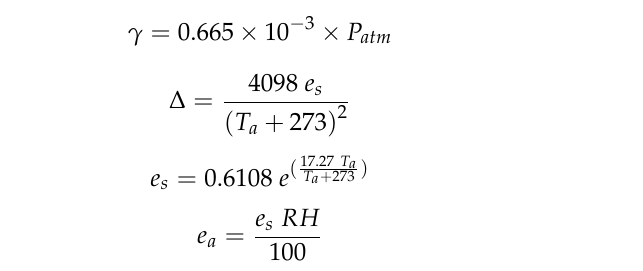
Figure 2. Image of Lake Nasser, south of Aswan, Egypt (22°25′ N 31°45′ E) .